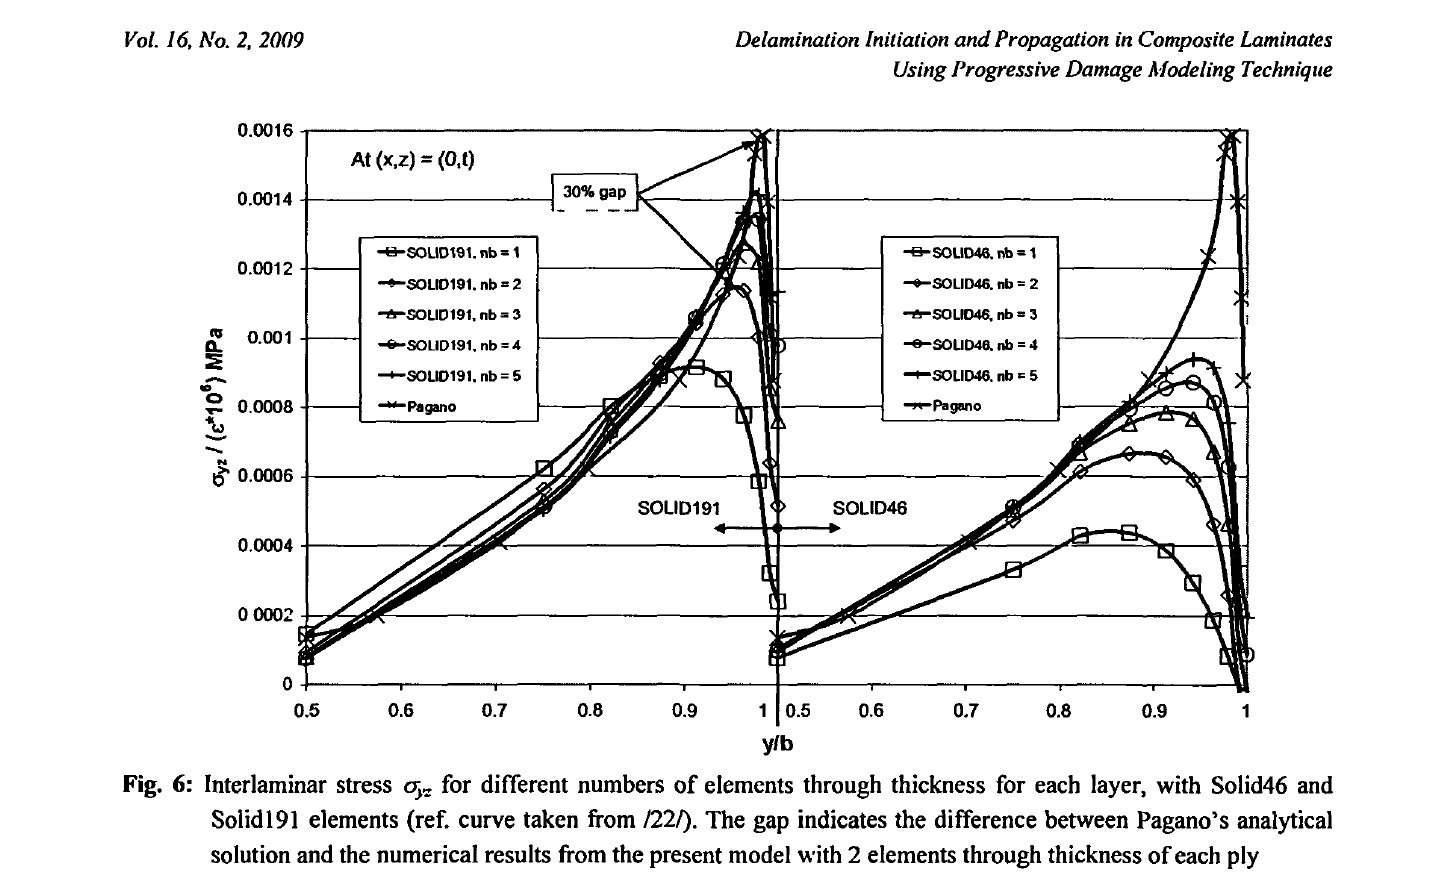
Fig. 6: Interlaminar stress 05, for different numbers of elements through thickness for each layer, with Solid46 and Solidl91 elements (ref. curve taken from fill). The gap indicates the difference between Pagano's analytical solution and the numerical results from the present model with 2 elements through thickness of each ply Numerical study on the use of